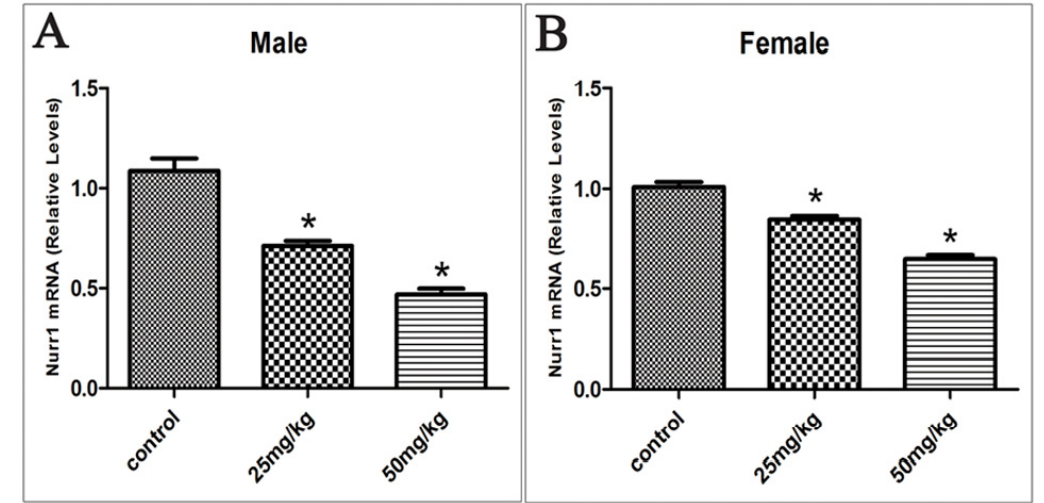
Figure 2. Offspring’s Nurr1 mRNA relative expression levels in the ventral midbrain in males ( A ) and females ( B ) exposed to ATR during gestation and lactation. ( n = 10) * p < 0.05.